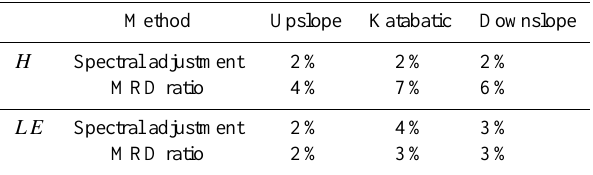
Table 3. Evaluation of high-frequency losses in H ec and LE ec fluxes. Spectral adjustment: percentage of flux losses estimated by adjusting an inertial subrange on the high-frequency end of the mean cospectra of w with θ and of w with q , for the three wind- regime subsets. Multi-resolution decomposition (MRD) ratio: me- dian ratio calculated over each subset of fluxes calculated at the shortest timescale of the MRD cospectra and the flux calculated at the gap scale of the MRD